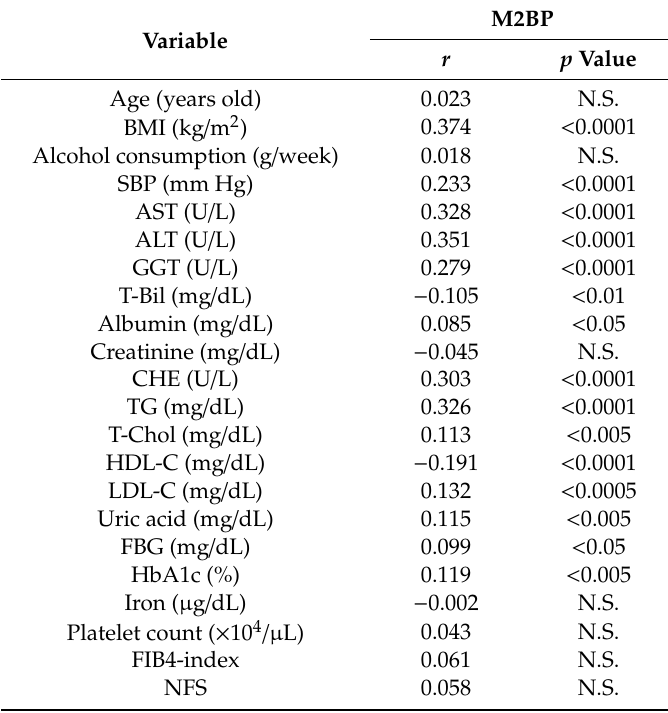
Table 2. Correlation between serum M2BP levels and various parameters at